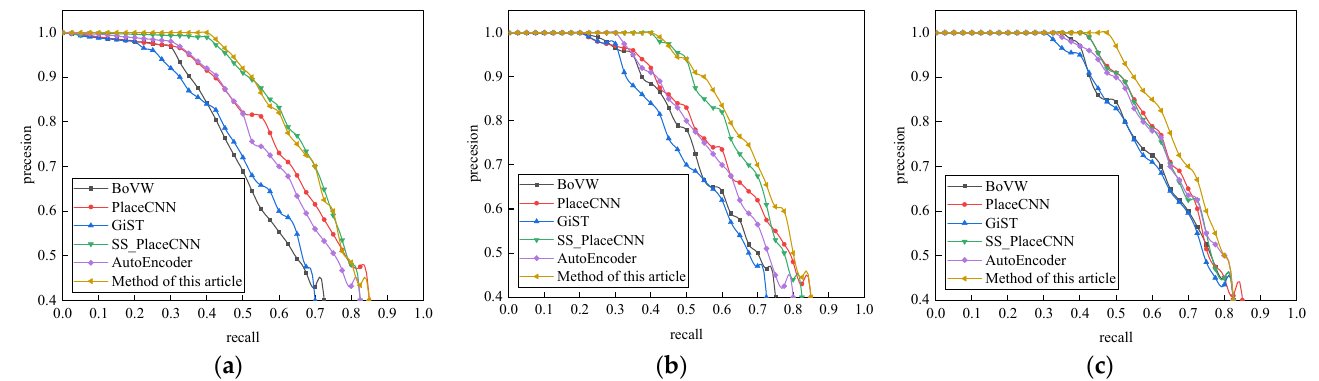
Figure 5. Comparison of the robustness of different closed-loop detection algorithms: ( a ) Gardens Point; ( b ) Mapillary; ( c ) Nordland.